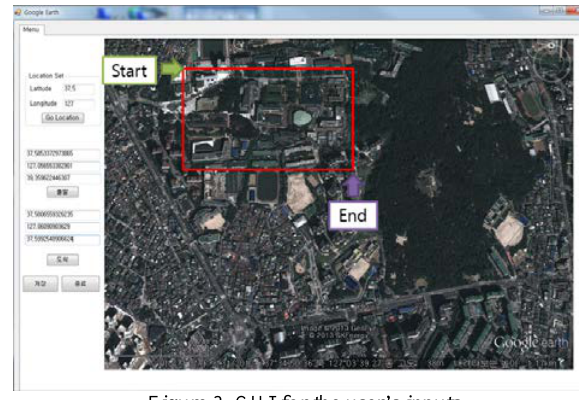
Figure 3. GUI for the user’s inputs